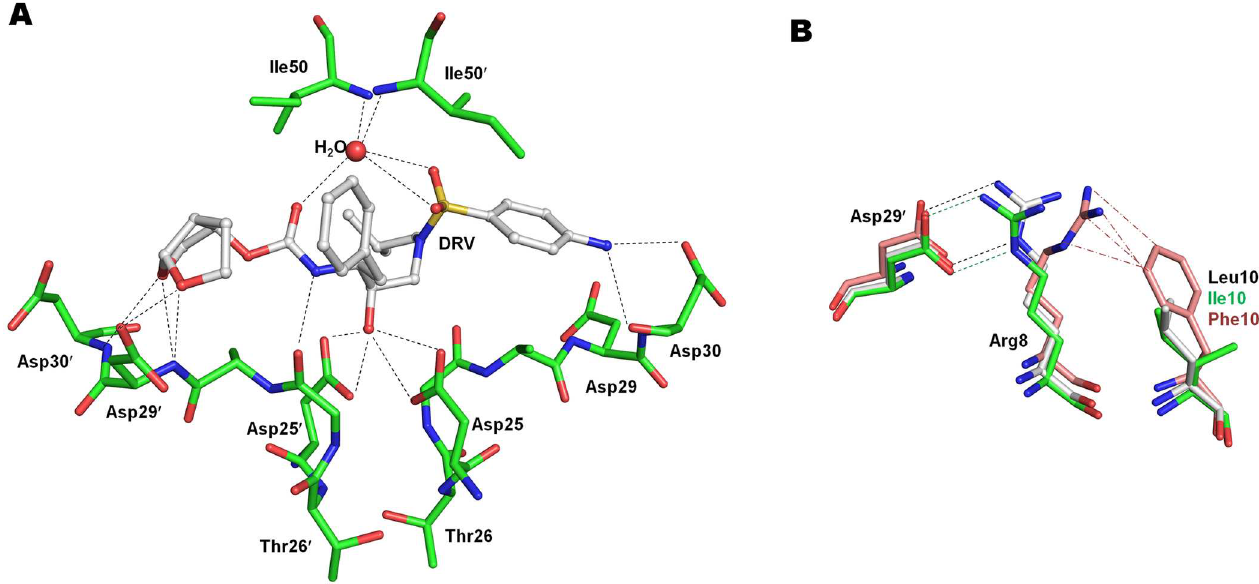
Fig 2. Hydrogen Bond Interactions of Darunavir with PR S17 and Effect of Leu10 Mutations. A. Hydrogenbond interactions of DRV with PR S17 . PR S17 is in stick representation with green carbonswhileDRV is shown in ball and stick with white carbons. For the sake of clarity only one conformation of DRV and Ile50 of PR S17 /DRV are shown. The hydrogenbond interactions of the second DRV are essentiallyidentical. The hydrogenbondsare shown as brokenlines. B. L10I mutation in PR S17 does not break the inter-monomerion pair betweenArg8 and Asp29 0 unlike L10F in PR20. Wild-type PR is shown with grey carbons, PR S17 as green carbonsand PR20 as salmon carbons. The van der Waals contacts are representedby (- (cid:1) -) line. The minor conformation of Arg8 in wild-type PR and PR20 and its interactions with Asp29 0 are omitted for clarity.